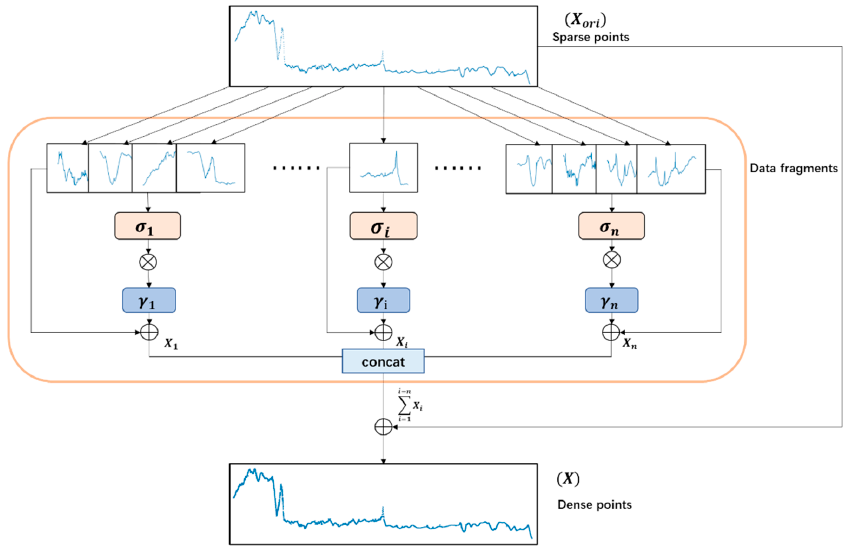
Figure 3. Flow chart of sliding window enhancement method 𝑿 𝒐𝒓𝒊 = ( 𝑥 1 , 𝑥 2 , …, 𝑥 N ) is the input vector of the target’s infrared characteristic data with length N, which is represented as sparse points in Figure 3. The original time series is sliced into data fragments 𝒙 1 = ( 𝑥 (cid:2869) , 𝑥 (cid:2870) ,…, 𝑥 (cid:3041) ) 𝒙 2 = ( 𝑥 (cid:2870) , 𝑥 (cid:2871) ,…, 𝑥 (cid:3041)(cid:2878)(cid:2869) ), 𝒙 𝒊 = ( 𝑥 (cid:3036) , 𝑥 (cid:3036)(cid:2878)(cid:2869) ,…, 𝑥 (cid:3036)(cid:2878)(cid:3041) ) according to a certain length 𝑛 , where 𝑥 (cid:3036) refers to the first frame of each sliced sequence. Here, 𝑛 can be set according to the total length of the sequence. In this paper, one slice is used every 500 frames. At the same time, each slice overlaps 100 frames of data of the